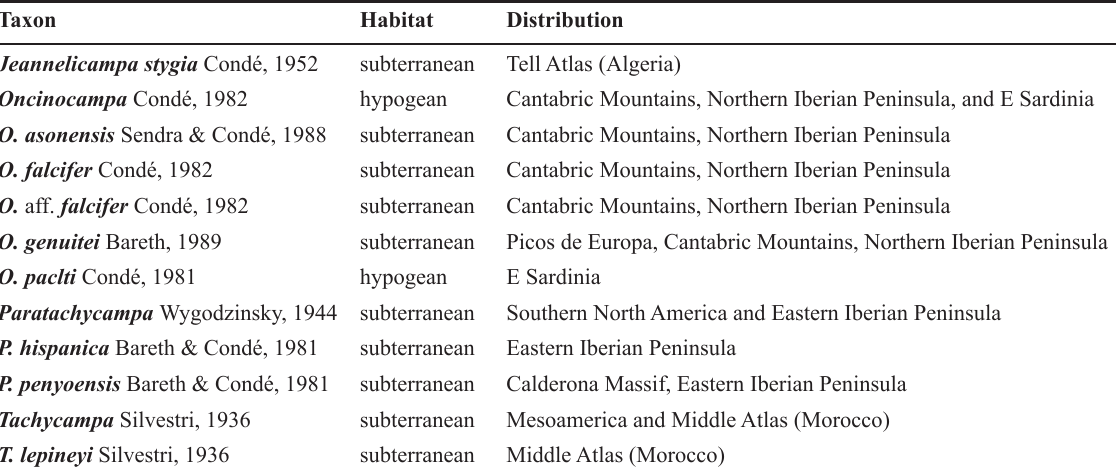
Table 14. Tachycampoid species and affinis forms in the Euro-Mediterranean